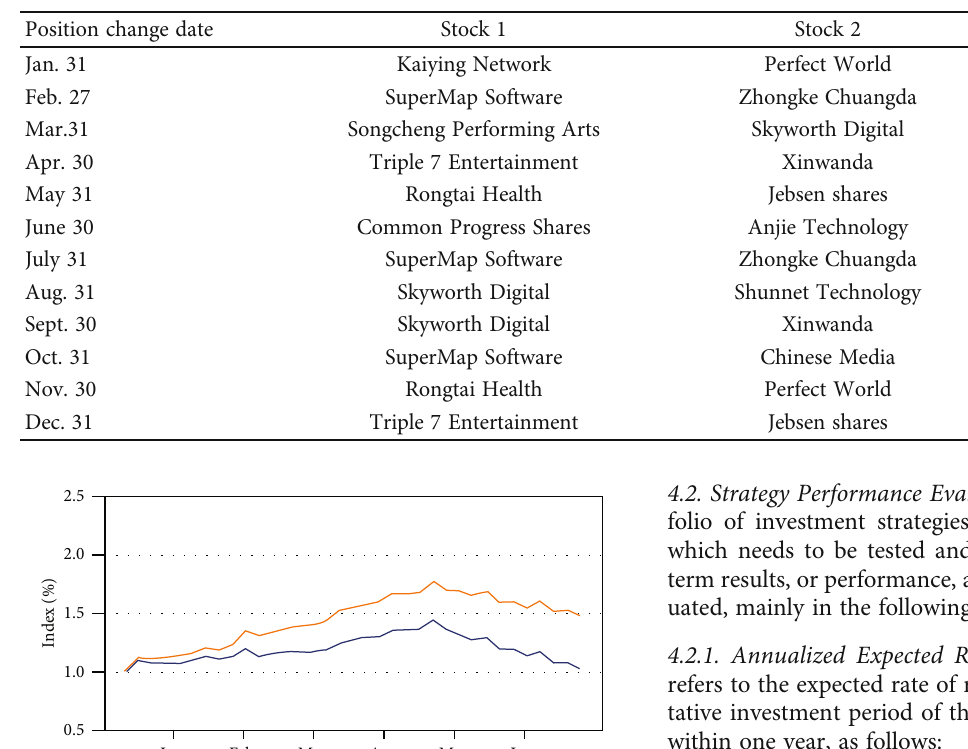
Table 12: Portfolio selection by investment strategy under di ff erent cycles.